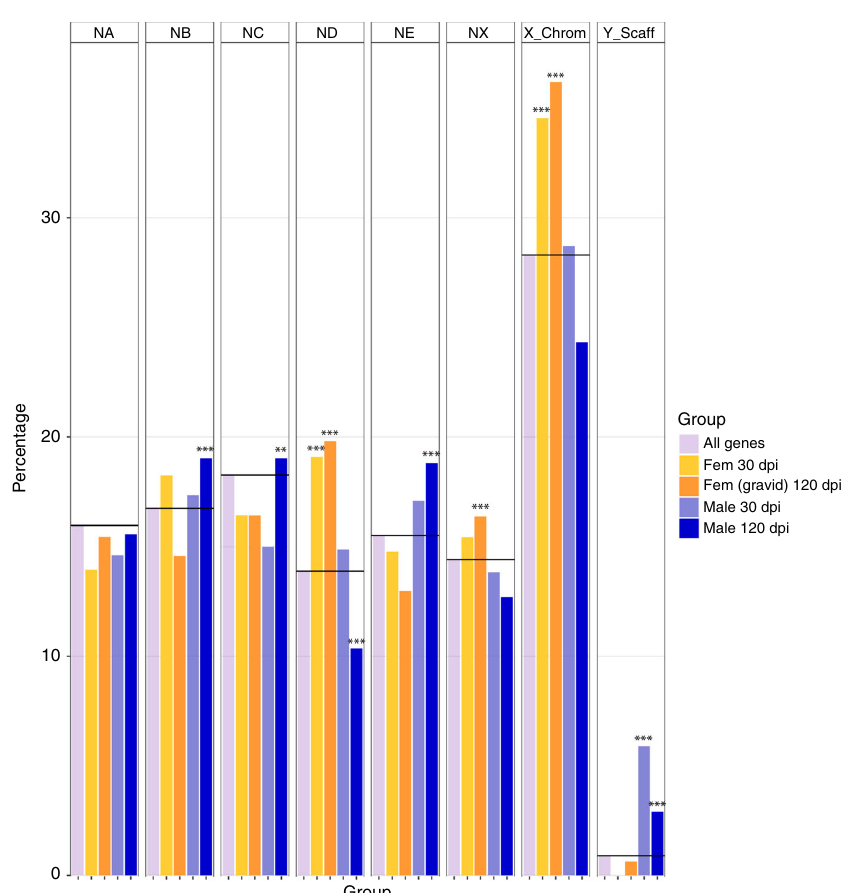
Fig. 4 Sex-biased gene enrichment. The percentage of male and female sex-biased genes at 30 and 120 dpi are shown relative to each Nigon element as well as the X chromosome and the Y-speci fi c contigs. The percentage of sex-biased genes is compared to total genes on each particular Nigon element, chromosome, or set of contigs, which is shown as the black line. The stars represent signi fi cant statistical enrichment or depletion of sex-biased genes on that particular element as determined by Fisher ’ s exact